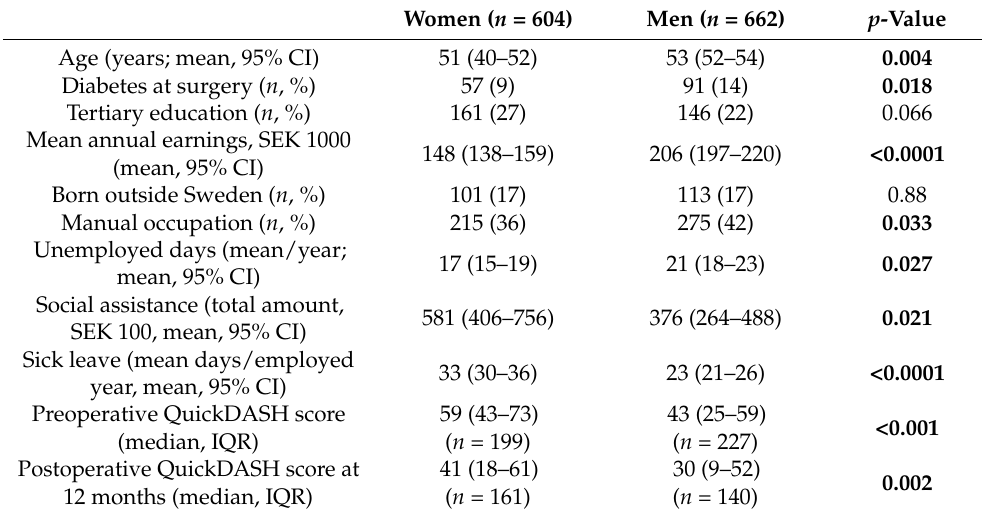
Table 3. Socioeconomic factors in 1266 patients with surgically treated ulnar nerve entrapment.